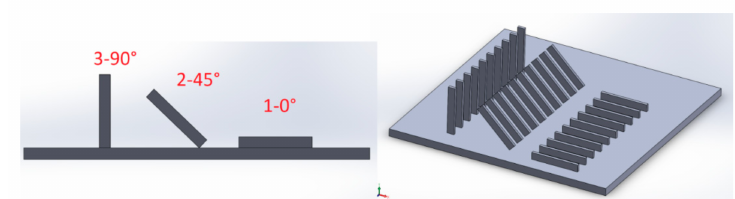
Figure 1. Arrangements (orientations & positioning) of investigated samples on the experimental